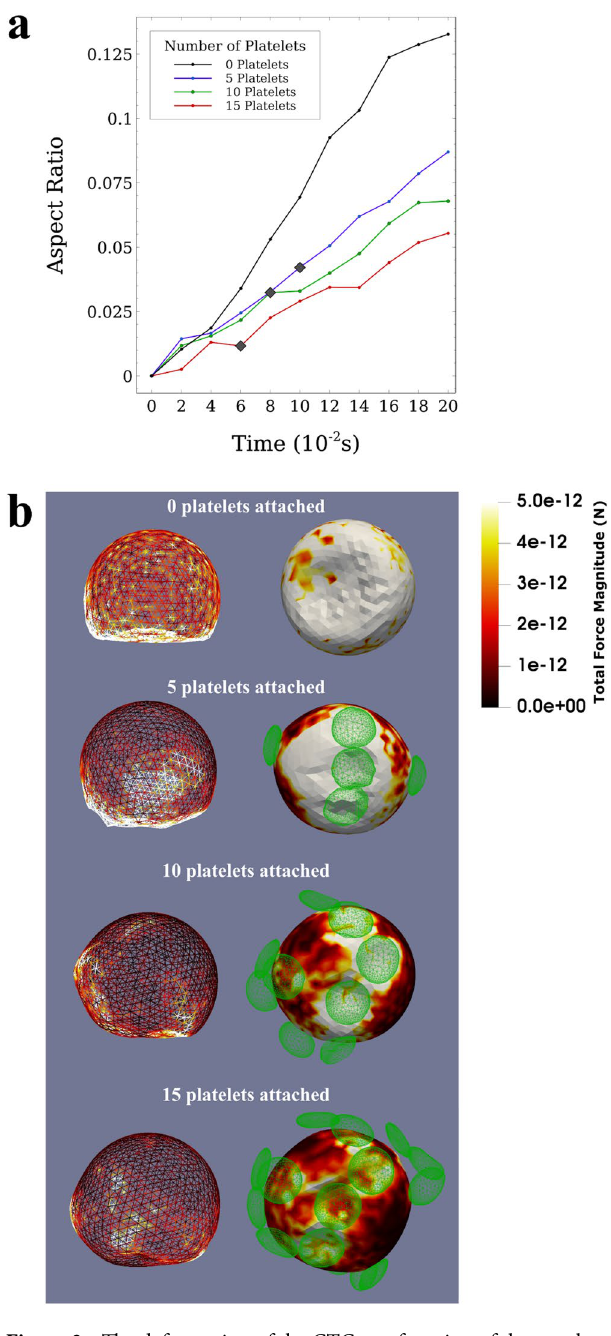
Figure 3. The deformation of the CTC as a function of the number of attached platelets and the force distribution on the membrane of the CTC. ( a ) Evolution of the aspect ratio with time shows the deformation of CTCs over the simulation time for different numbers of attached platelets. The aspect ratio is calculated L B using ς − L B . Also, the firm adhesion instance is indicated with grey diamond for the cases in which there = + are attached platelets and the firm adhesion occurs. The graph shows that the attached platelets can reduce the aspect ratio (i.e. deformations) of the CTC with no attached platelet to less than half when 15 platelets are attached to the CTC. Attached platelets can preserve the integrity of the CTC and reduce the deformations of the CTC by making the force distribution on the CTC membrane homogeneous; ( b ) Front view (on the left side) and bottom view (on the right side) of the CTC showing its shape deformation in the rolling motion (for the CTC with no attached platelets, top) and in firm adhesion state (for CTCs with 5, 10, and 15 attached platelets). The membrane is coloured with the distribution of the magnitude of the total force on the CTC. External forces applied on small areas of CTC membrane can damage the CTC during the adhesion process. Platelets attachment to the CTC reduces the maximum force applied to the CTC by making the force distribution on CTC increasingly